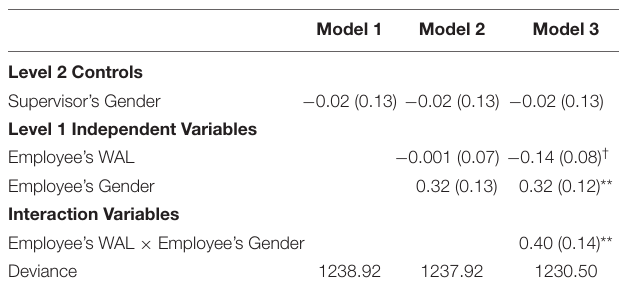
TABLE 4 | Study 2 multilevel regression